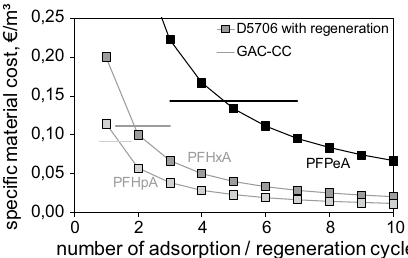
Fig. 11 Specific material costs for the elimination of PFPeA (black), PFHxA (dark grey) and PFHpA (light grey) as a function of the number of adsorption and regeneration